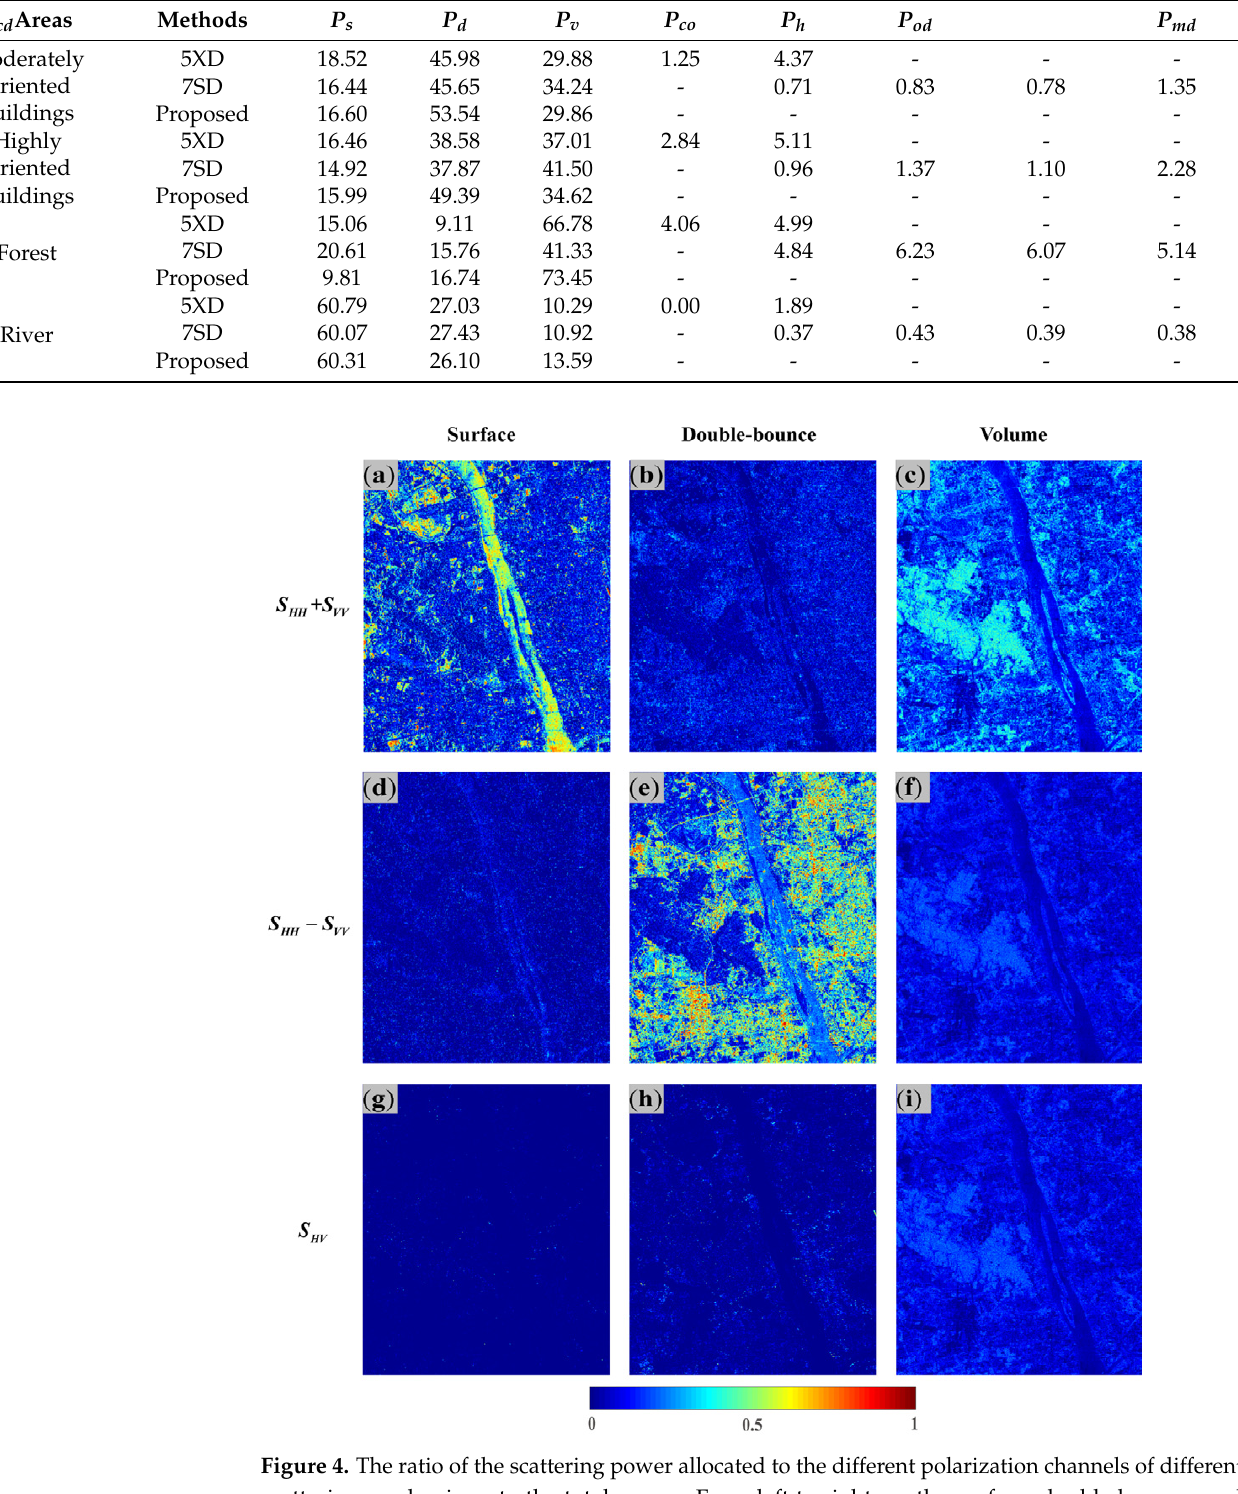
S S + , S S − , and S polarizations. ( a – c ) Power HH VV HH VV HV